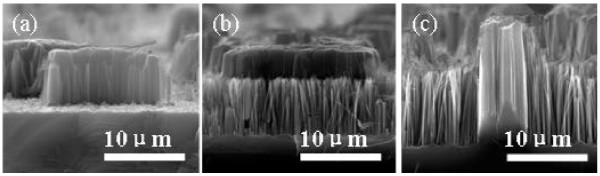
Cross-sectional SEM images. Silicon samples are etched in the solution containing 4.6 M HF, 0.02 M AgNO3, and 0.05 M KMnO4 for different reaction times. (a) 15 min; (b) 45 min; (c) 90 min.